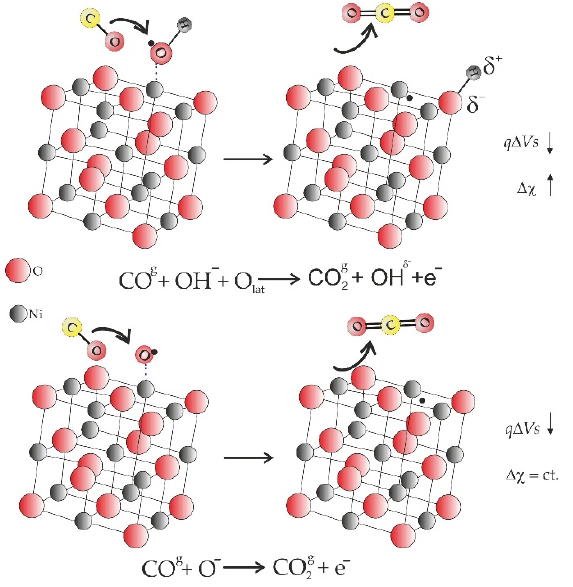
Figure 10. Intuitive cartoon of CO-sensing mechanism with NiO calcined at 500 °C.